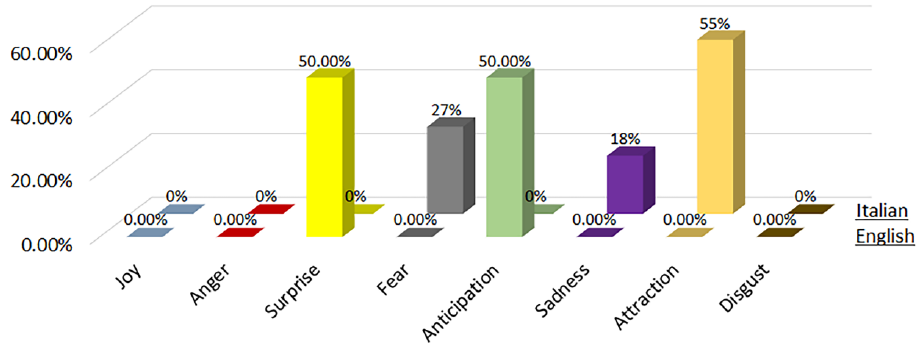
Figure 9. Percentage distribution of every primary emotion for English and Italian words during phase 2 of COVID-19 pandemic.